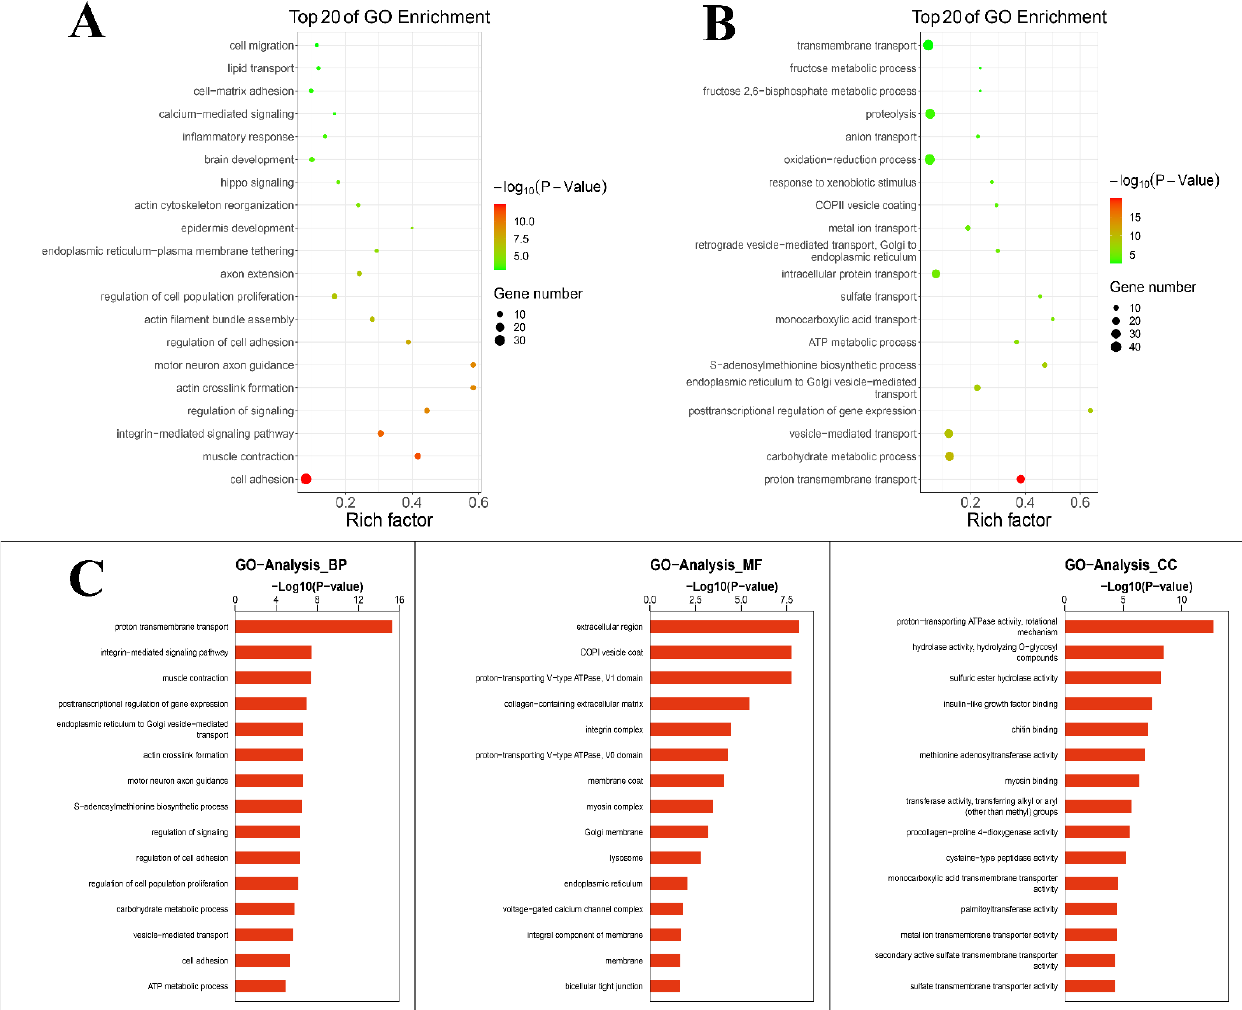
Figure 2. GO enrichment analysis. ( A ) GO enrichment analysis of down-regulated genes. ( B ) GO enrichment analysis of up-regulated genes. ( C ) A summary of the biological processes, molecular functions and cellular components of differentially expressed genes.